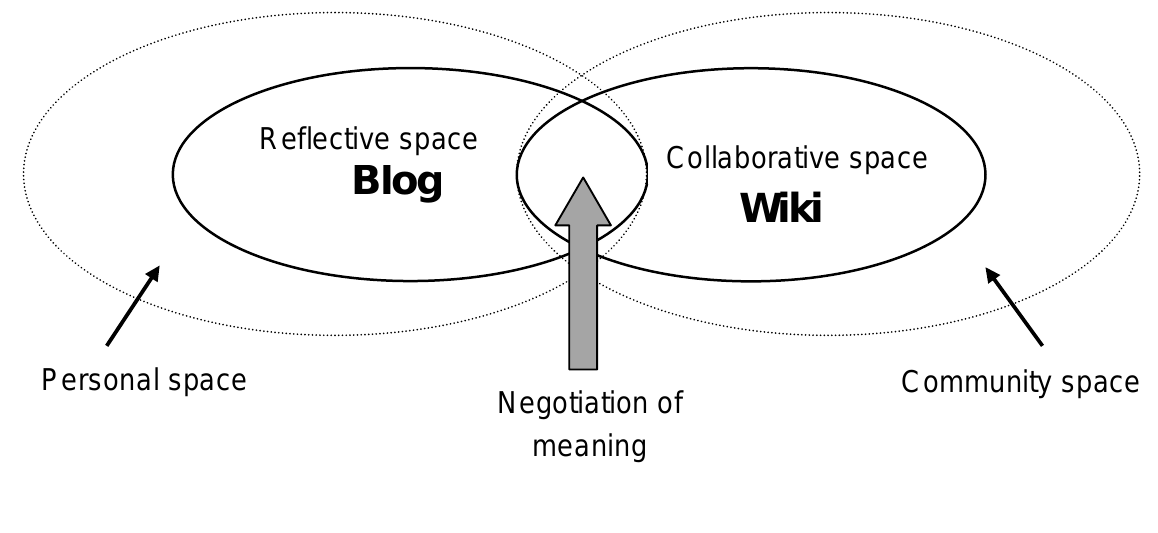
Figure 1. Learning spaces and negotiated